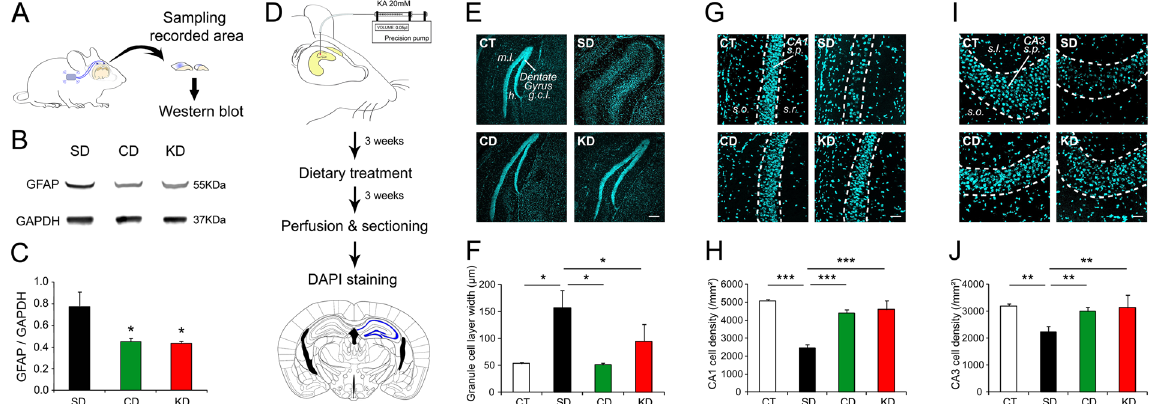
Figure 5. CD treatment rescues cytological and molecular correlates of chronic epilepsy. ( A ) Tissue obtained from the recording site of KA mice was collected for immunoblotting. (B,C ) Expression of GFAP was significantly reduced in mice treated with KD and CD (n = 4 per group, all p < 0.05). ( D) KA mice